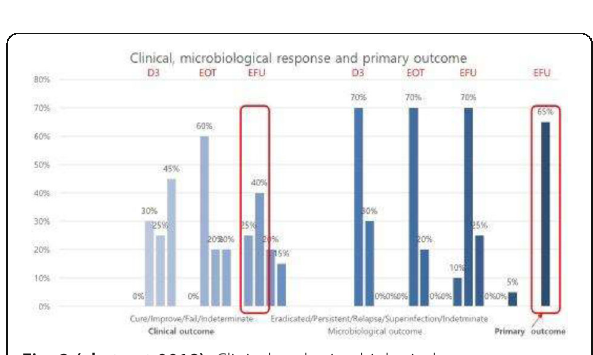
Fig. 2 (abstract 0018). Clinical and microbiological